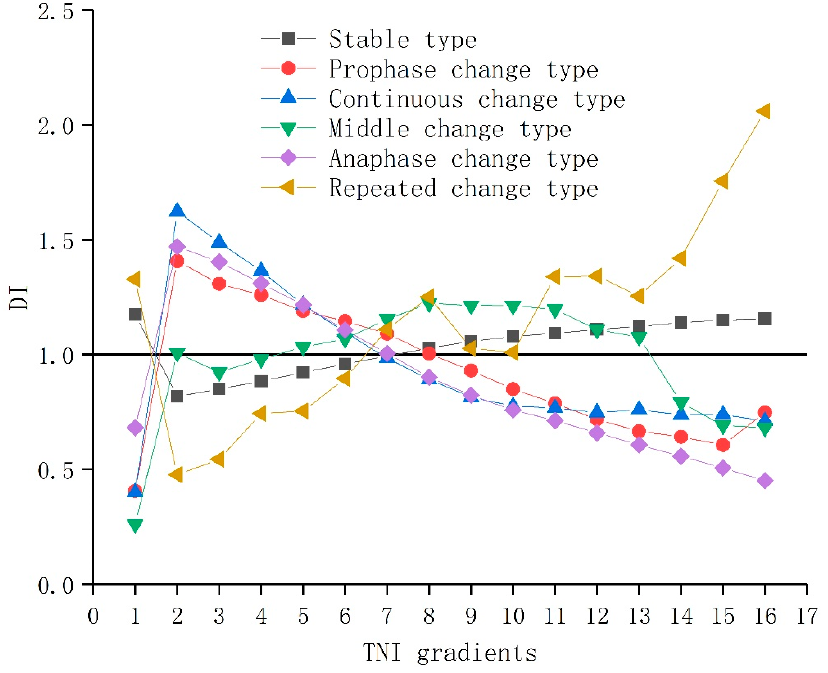
Figure 7. The distribution index of LER change Tupu with different terrain gradients.